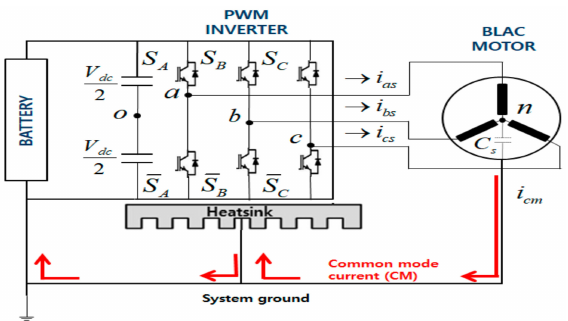
Figure 1. Three-phase voltage source inverter (VSI)-fed brushless alternating current (BLAC) motor drive.